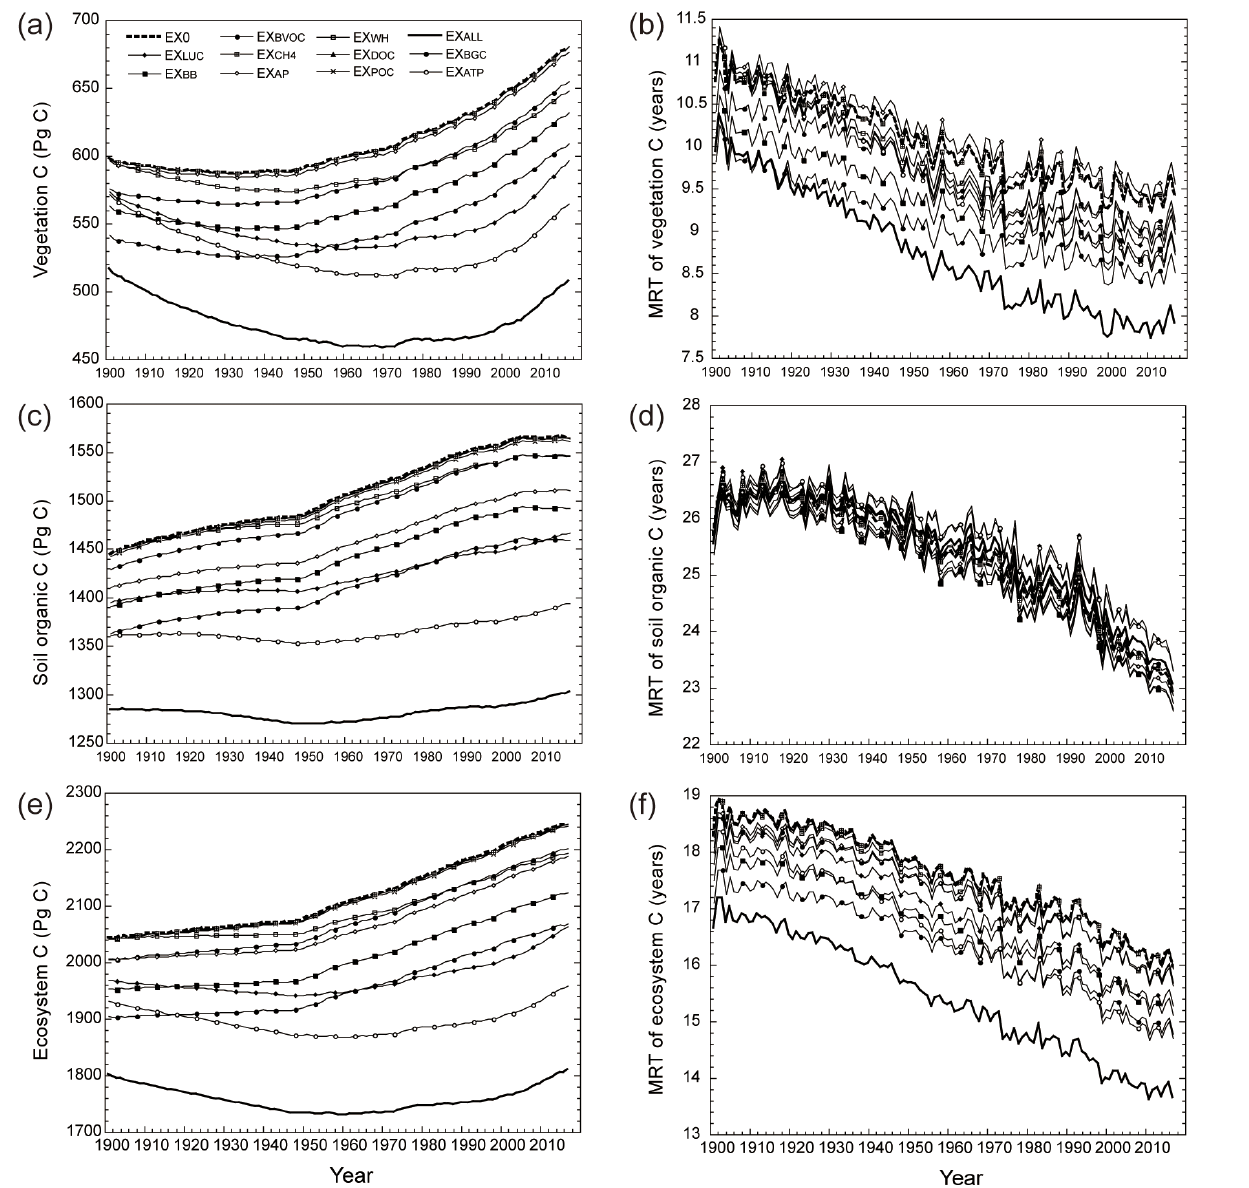
Figure 4. Time series of simulated carbon stocks and their mean residence time (MRT) in different experiments. (a) Vegetation biomass and (b) its MRT, (c) soil organic carbon and (d) its MRT, and (e) total ecosystem carbon stock and (f) its